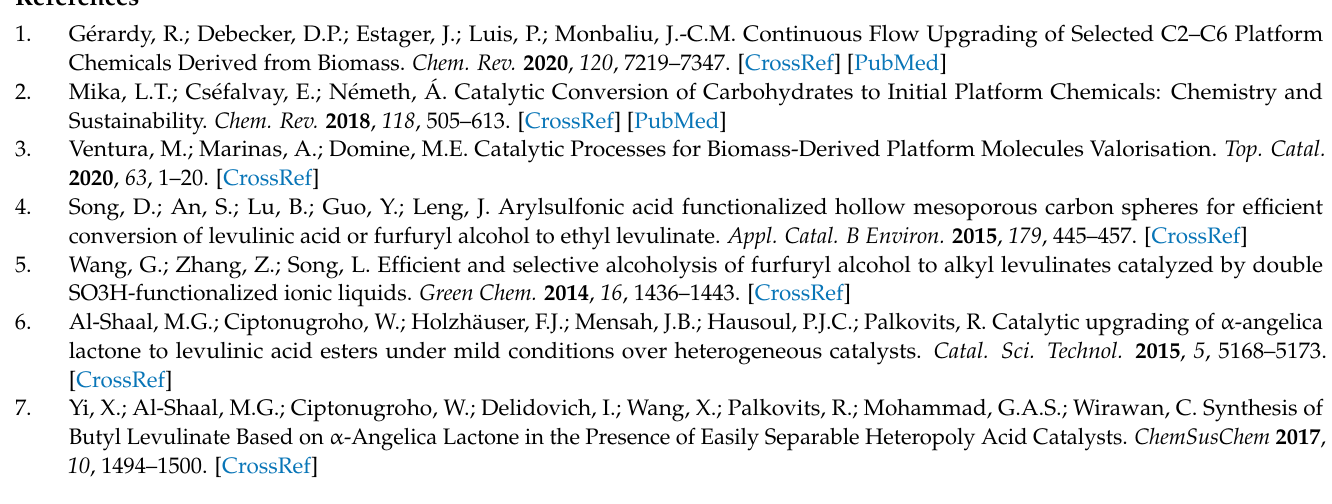
Figure S5: Comparison of the course of the reaction of a model reaction with the use of